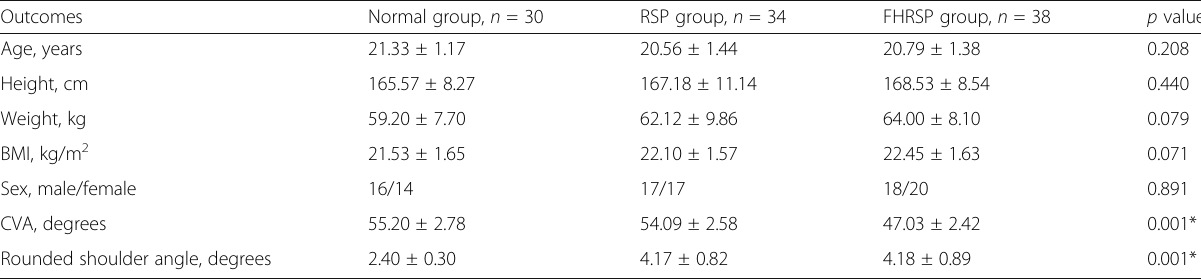
Table 1 Descriptive characteristics for all dependent variables for each group Outcomes Normal group, n =